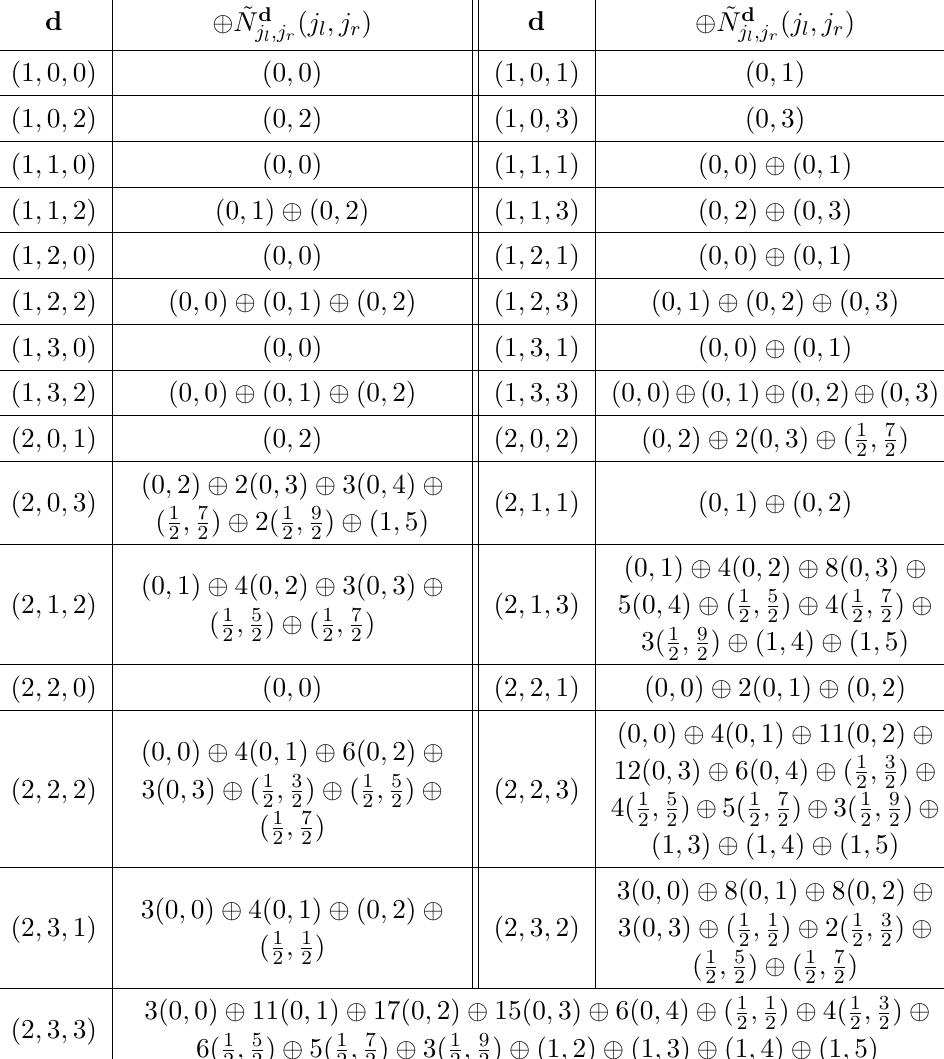
Table 9 . Spectrum of the bound states to the fundamental Wilson loop in the SU(3) 7 theory up to d 1 ≤ 2 and d 2 , d 3 ≤ 3 . Here, d = ( d 1 , d 2 , d 3 ) labels the BPS states with fugacity Q − 1 / 3